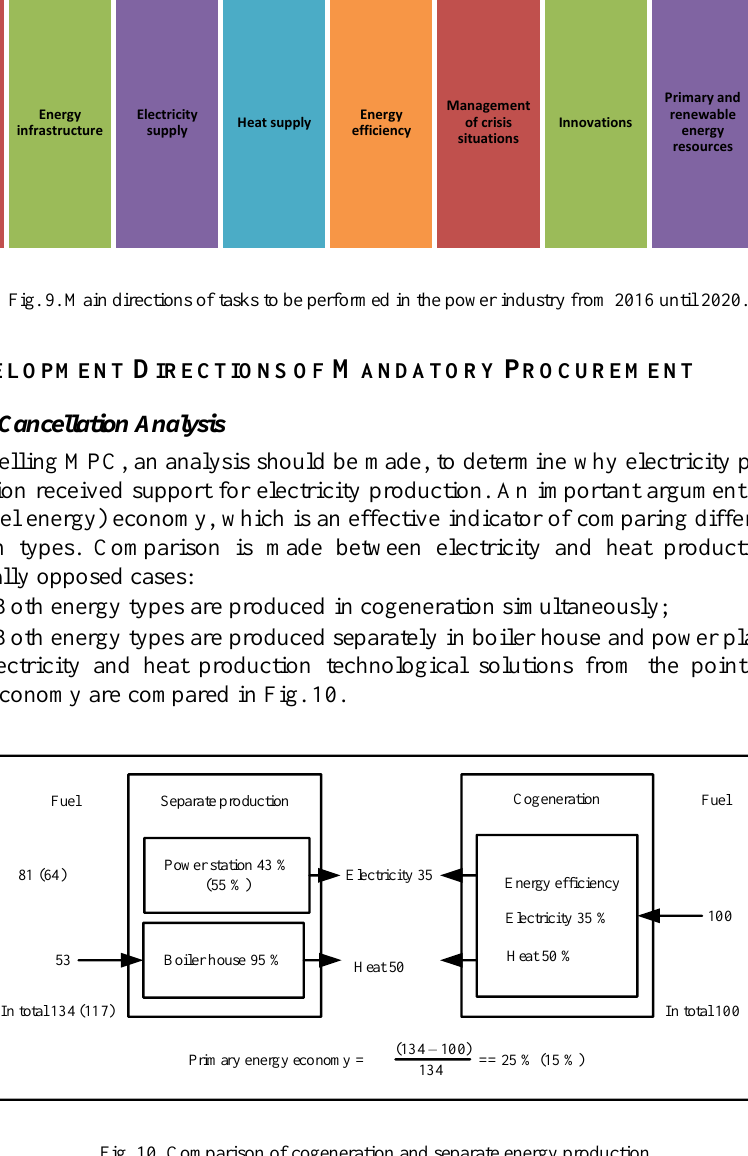
Fig. 10. Comparison of cogeneration and separate energy